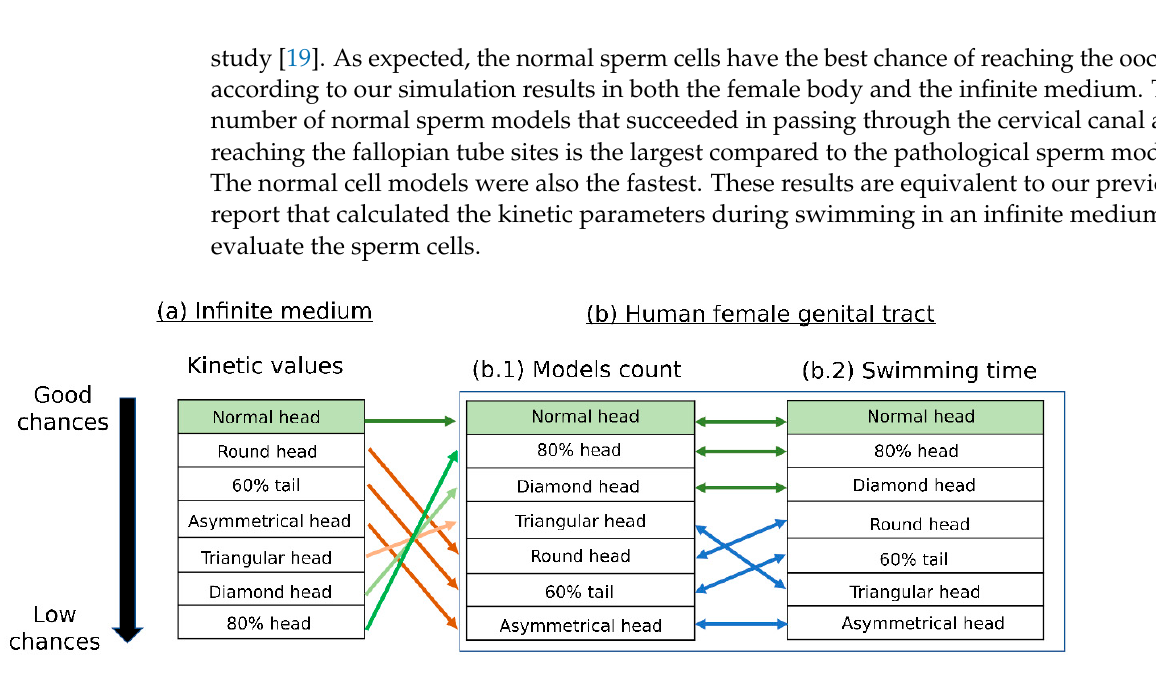
Figure 7. Scoring of sperm-pathology categories according to the cell chances of reaching the oocyte. Scoring of the various sperm cell pathologies based on the kinetic values of the infinite medium ( a ) [19], the model count ( b.1 ), and the swimming time ( b.2 ) results of the human female cervical canal and uterine cavity simulation. The arrows indicate changes in the scoring due to chances of reaching the